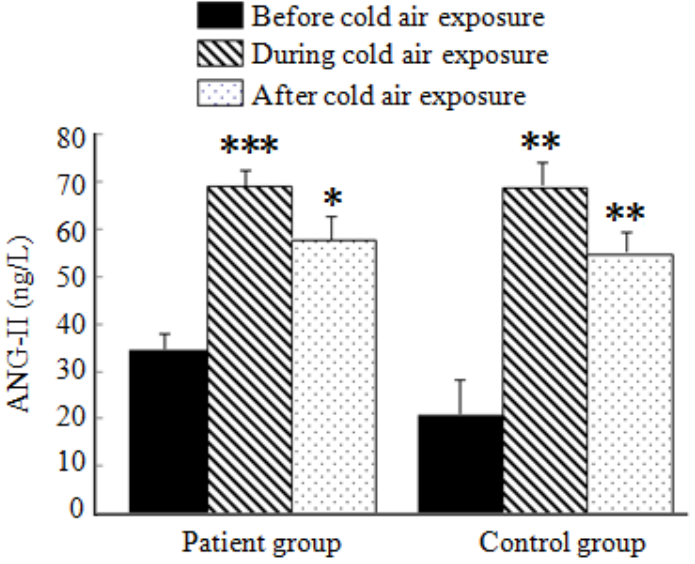
Figure 4. Average ANG-II levels in the patient and control groups during a cold air event.